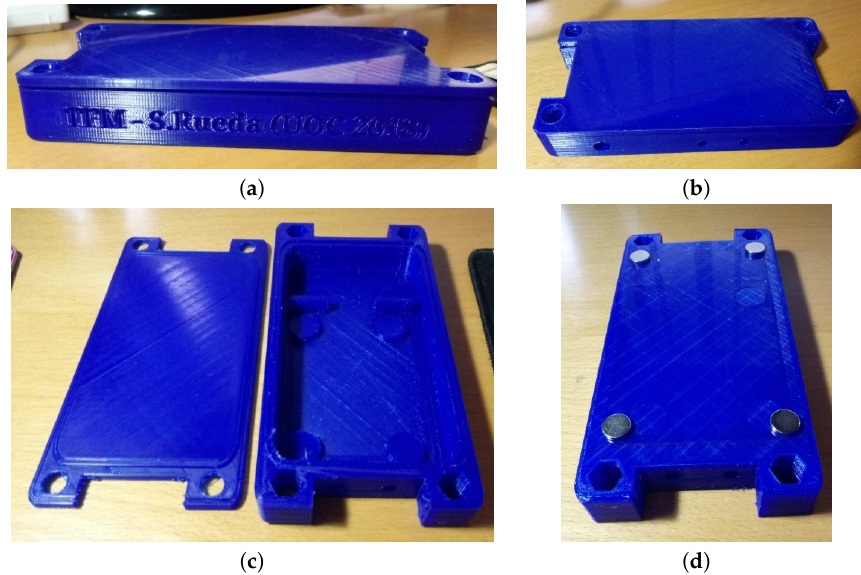
Figure 10. Box designed to house the electronics. ( a ) Side view of the case; ( b ) the holes for the output of two thermistors and switch are observed; ( c ) the inside of the box with the compartment to house the 9 V battery, the PCB brackets, and two other front holes for the thermistor output; ( d ) back of the case with its four neodymium magnets to fix the case to the metal dome.